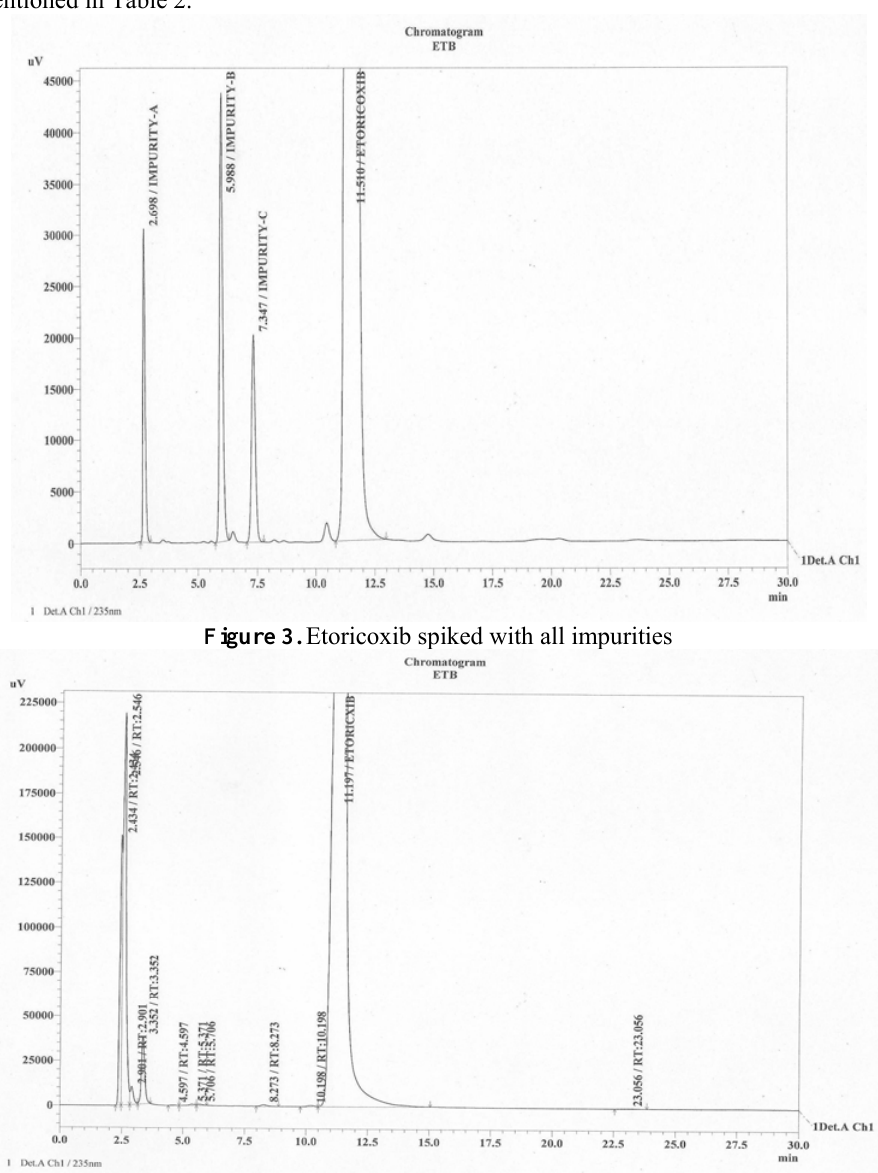
Figure 4. Etoricoxib base degradation sample 2 mL of 1 N NaOH (3 h at 80